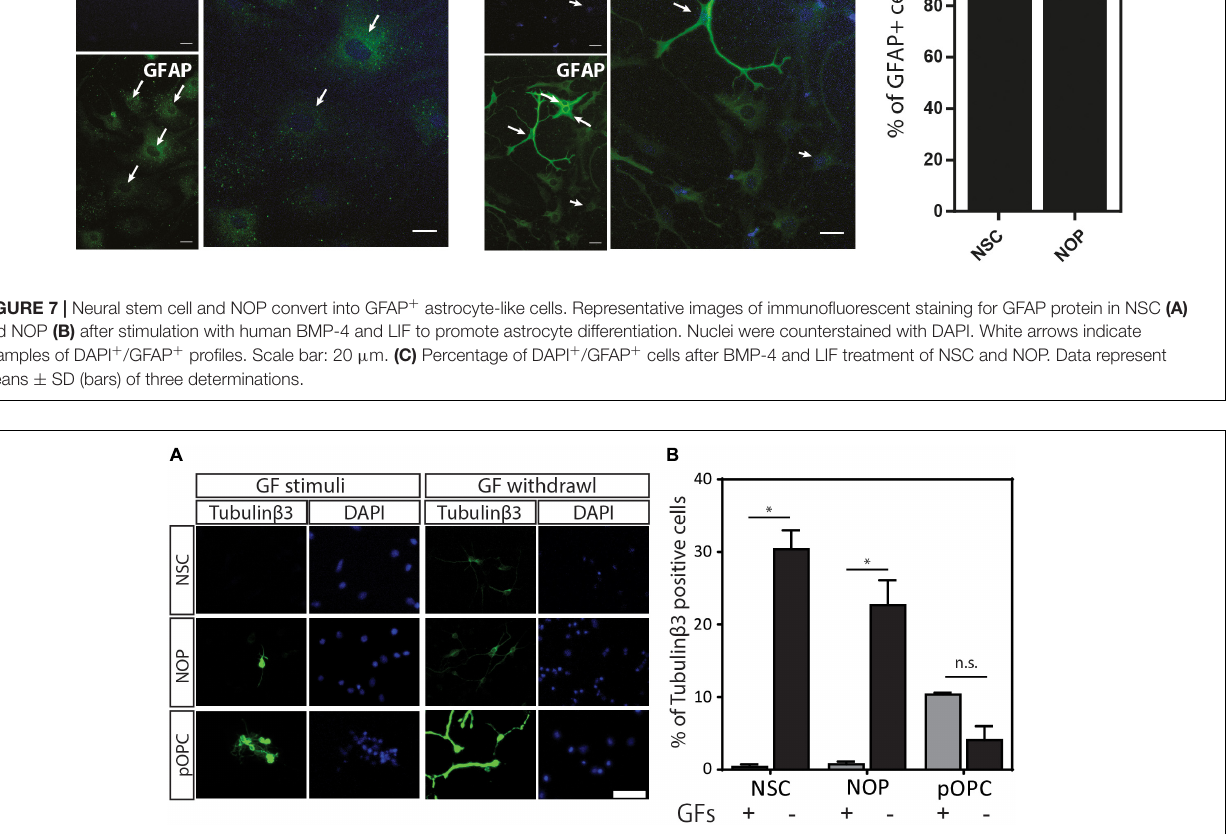
FIGURE 8 | Neurogenic potential of NOP. (A) Representative images of immunofluorescent staining for neuronal marker protein ßIII-tubulin protein in NSC, NOP, and pOPC after culturing in growth factor-depleted basal medium to promote spontaneous neuronal differentiation. Nuclei were counterstained with DAPI. Tubulin β 3: β III-tubulin protein; Scale bar: 50 µ m. (B) Percentage of β III-tubulin-positive cells after culture of NSC, NOP, and pOPC in conditions promoting neurogenesis. Data represent means ± SD (bars) of three determinations. * P < 0.05; n.s., not